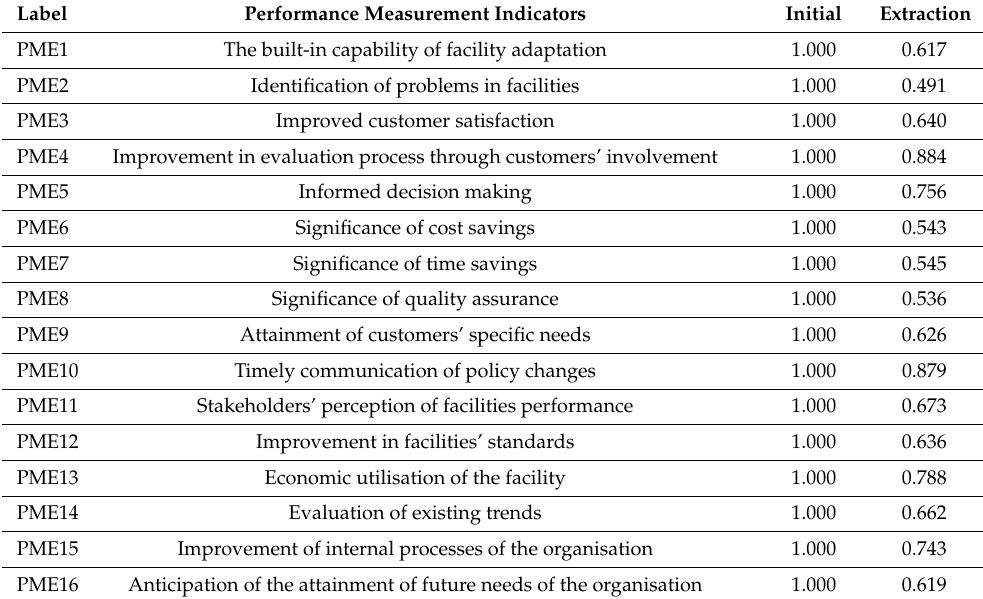
Table 3. Communalities.